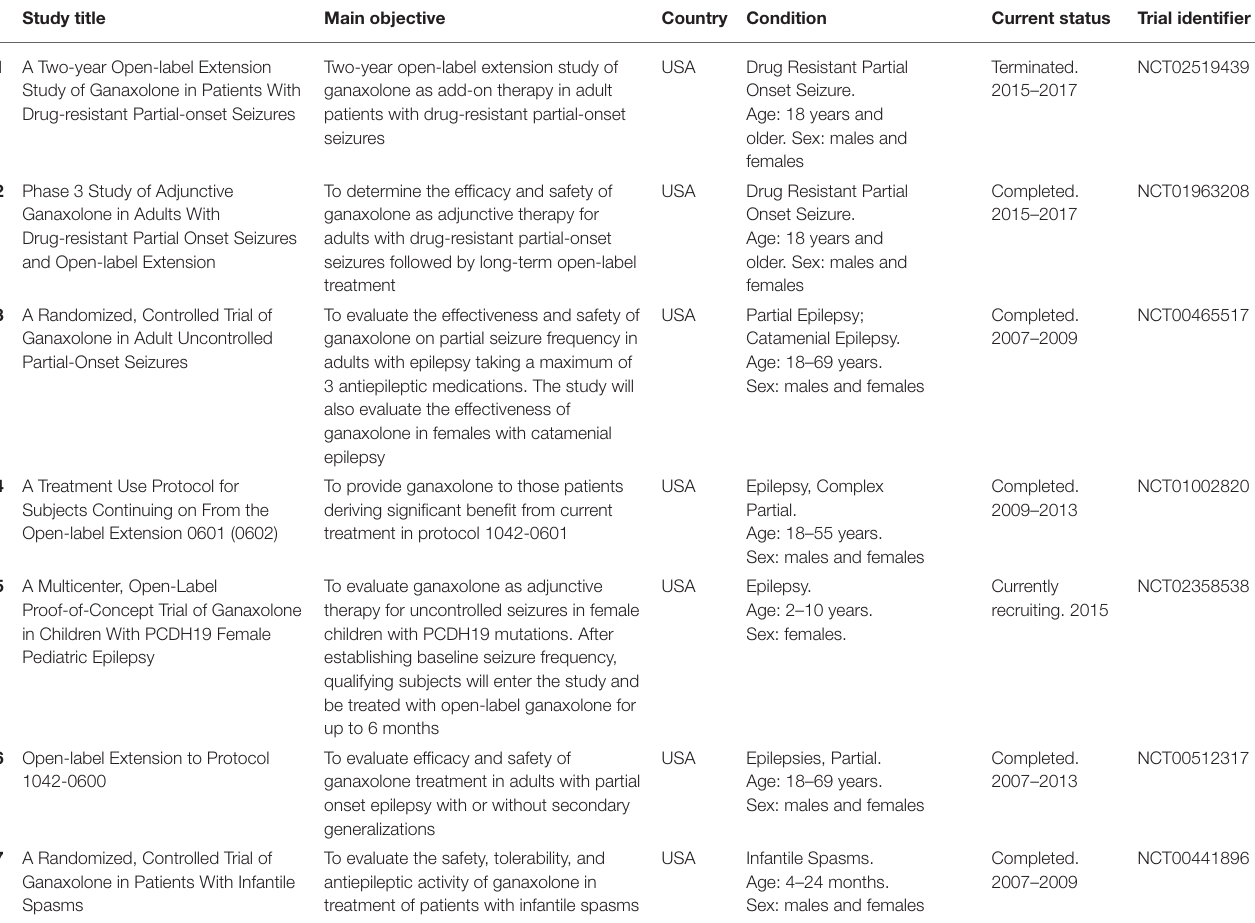
TABLE 1 | Clinical trial in which Ganaxolone is used to treat epilepsy in children and